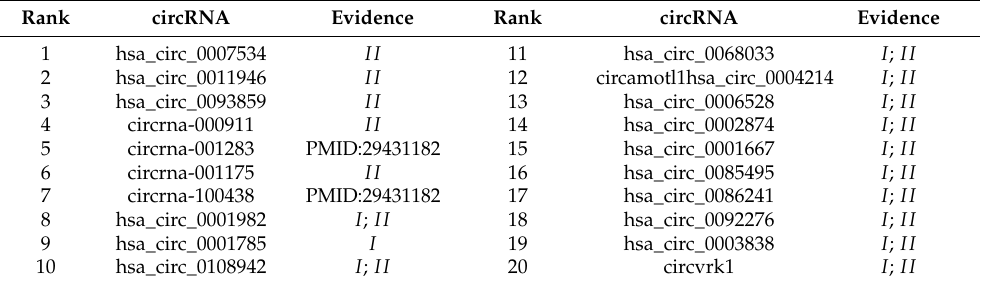
Table 4. Top 20 predicted circRNAs related to Breast cancer based on circR2Disease dataset.